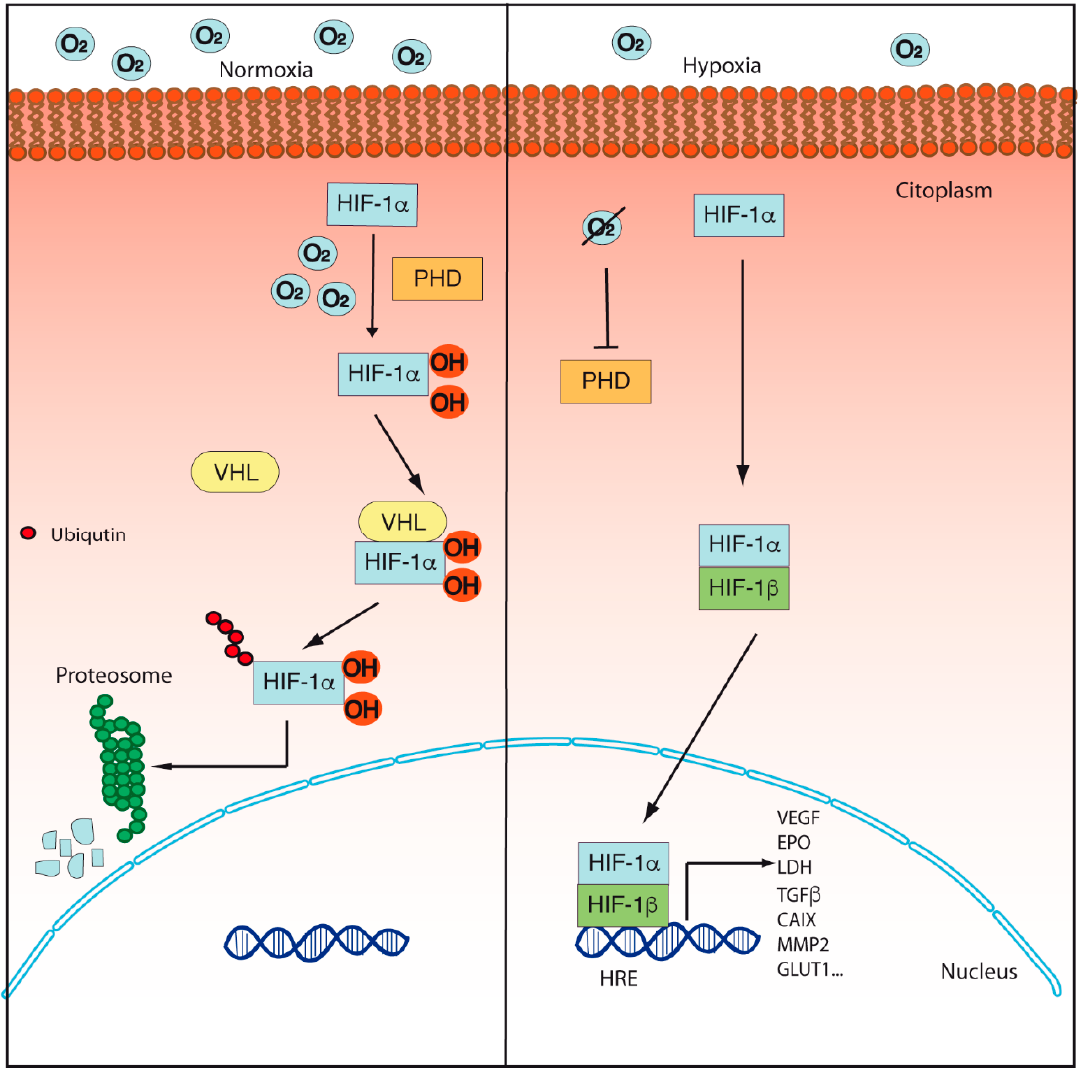
Figure 1. HIF-1 α pathway. In normoxia ( left ), HIF-1 α is hydroxylated by PHDs to be recognized by VHL, which adds ubiquitin units to send HIF-1 α to the proteosome to be degraded. In hypoxia ( right ), PHDs are inactivated and HIF-1 α is translocated to the nucleus, forming a dimmer with HIF-1 β to induce the transcription of several target genes. VEGF, Vascular Endothelial Growth Factor; EPO, erythropoietin; LDH, Lactate Dehydrogenase; TGF- β , Transforming Growth Factor β ; CAIX, Carbonic Anhydrase 9; MMP2, Matrix Metallopeptidase 2; GLUT1, Glucose transporter 1. The hydroxylation in proline 564 is recognized by the tumor suppressing protein von Hippel-Lindau (pVHL), which acts as an E3 ubiquitin ligase by adding ubiquitin residues to the HIF- α subunits, thus promoting their degradation (Figure 1) [17–20]. Loss of function or inhibition of pVHL expression prevents HIF-1 α degradation, which